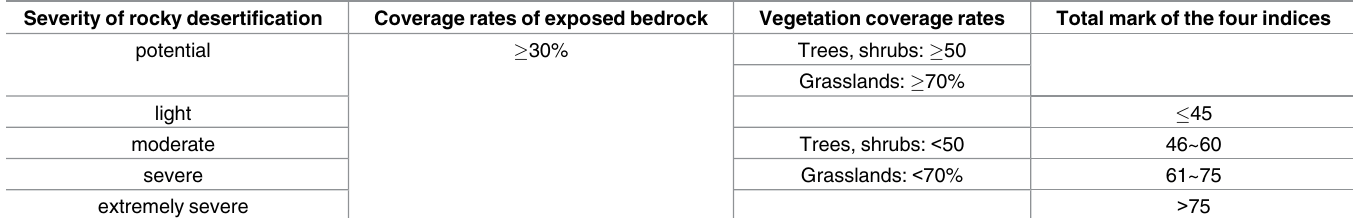
Table 2. Classification of the rocky desertification severity.